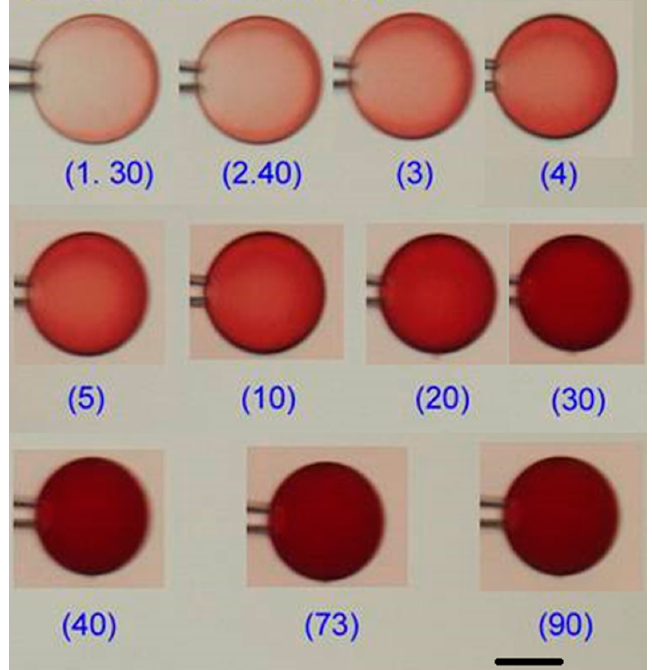
Figure 9. Microscopy images of PSS microsphere in a 729 ppm cytochrome solution (NaCl/tris buffer; pH 8.0, I = 10 mM) captured at different times in minutes as indicated. Scale bar = 50 µm.